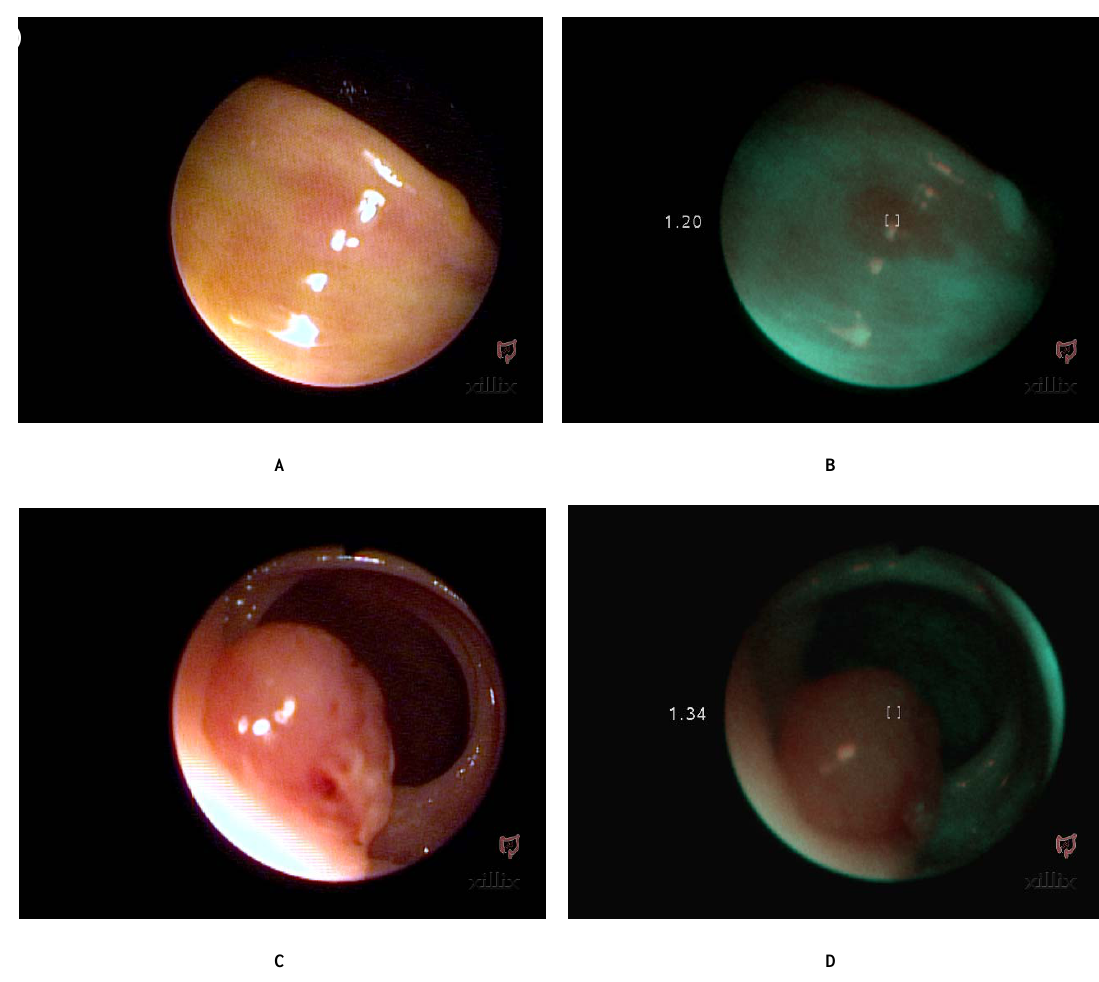
FIGURE 4. Typical example of (A) WLE image of a diminutive colonic adenoma and (B) the corresponding light-induced fluorescence image (pseudocolored) taken with the LIFE-II imaging system (Xillix Technologies Corp.). (C) The white light and (D) corresponding fluorescence image of a large colonic adenoma. Note the red fluorescence of both lesions compared with the cyan- colored normal mucosal background in both images.